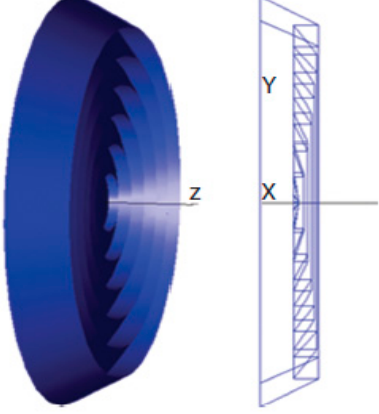
Figure 2. Design of the Fresnel lens.